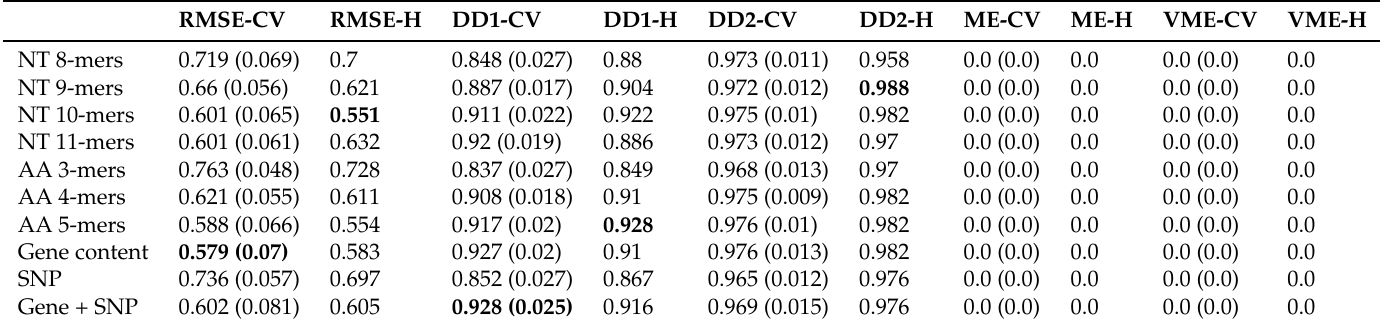
Table A49. K. pneumoniae –trimethoprim.